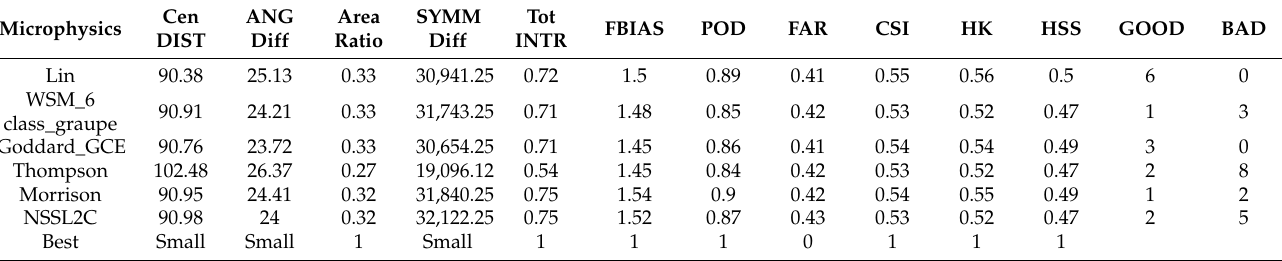
Table A4. Mode analysis using PERSIANN-CCS satellite-based